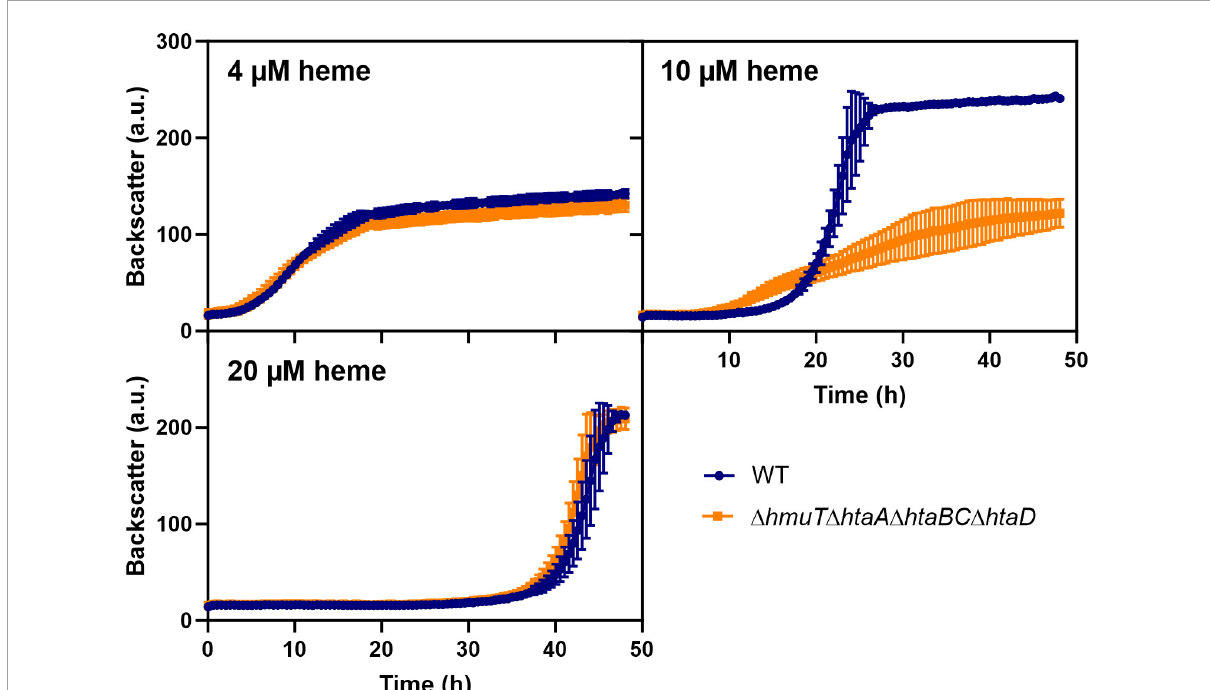
FIGURE6 Heme binding proteins contribute to heme tolerance. The C. glutamicum wild type (WT) (blue) and the heme binding deficient mutant (cid:49) hmuT (cid:49) htaA (cid:49) htaBC (cid:49) htaD strain (orange) were inoculated at a starting-OD 600 of 1 in CGXII medium containing 2% glucose and either 4, 10, or 20 µ M heme. Data represent the average of three biological replicates including standard deviations depicted as error